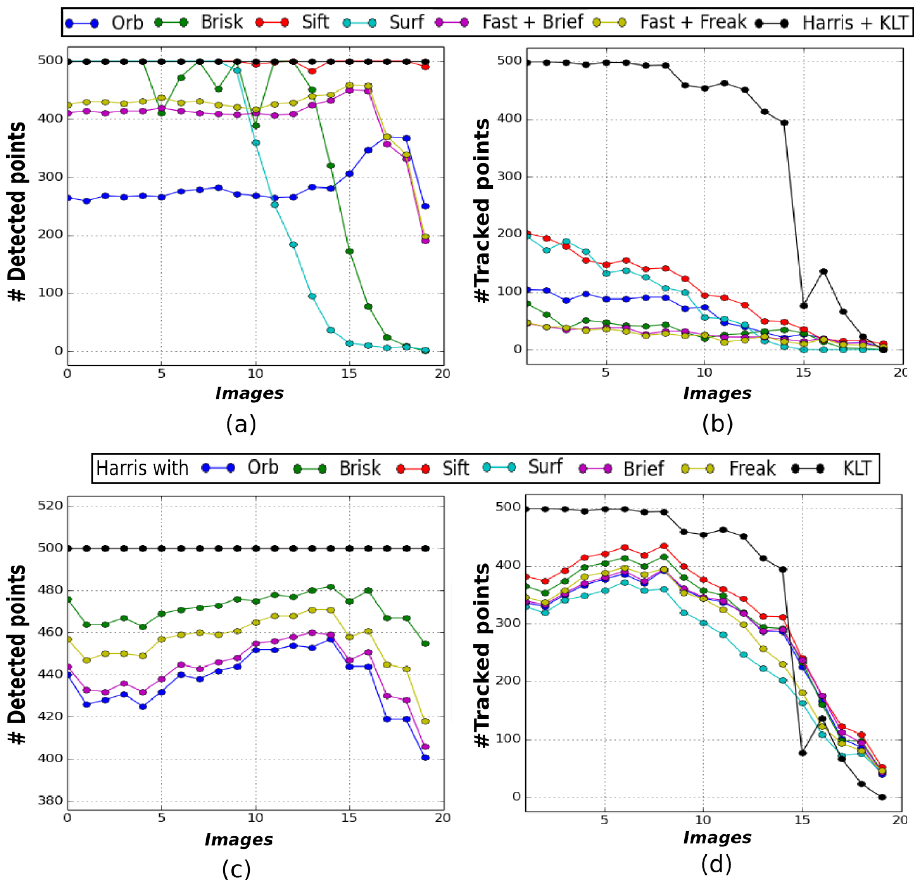
Figure 3. Features tracking methods evaluation on the TURBID dataset [24] (presented in Figure 2a). Graphs ( a ) and ( b ) illustrates number of features respectively detected and tracked with different detectors while ( c ) and ( d ) illustrates number of features respectively detected with the Harris corner detector and tracked as before (the SURF and SIFT curves coinciding with the Harris-KLT one in ( c